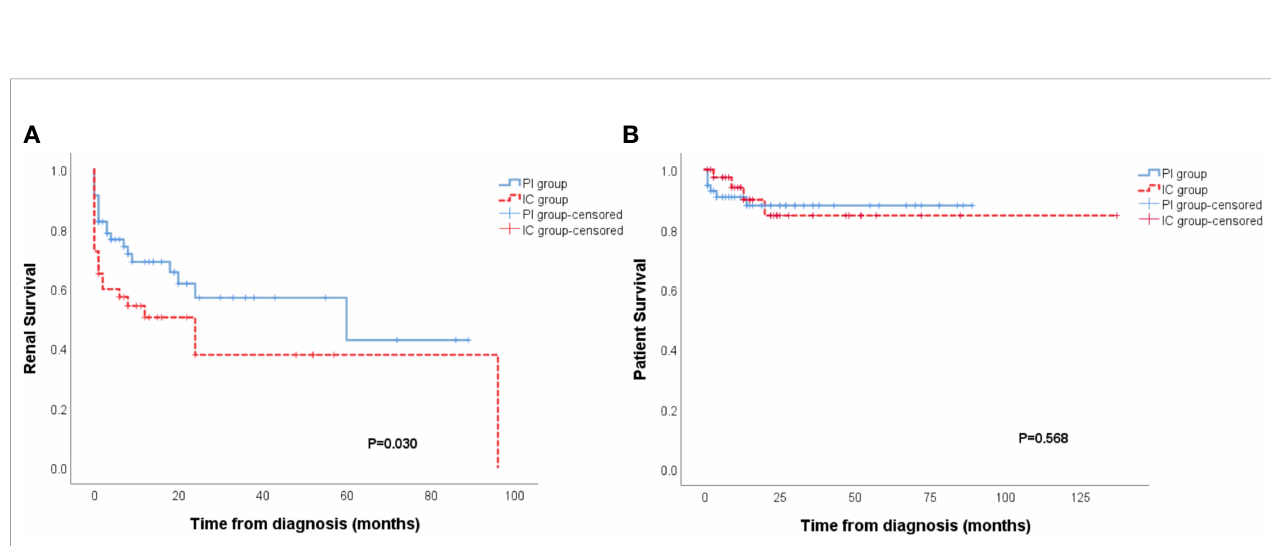
FIGURE 2 | Patients of the immune complex deposits (IC) group had a higher incidence of ESRD than the pauci-immune (PI) group (p = 0.030) (A) . No distinction of patient survival had been observed between PI and IC group (B)